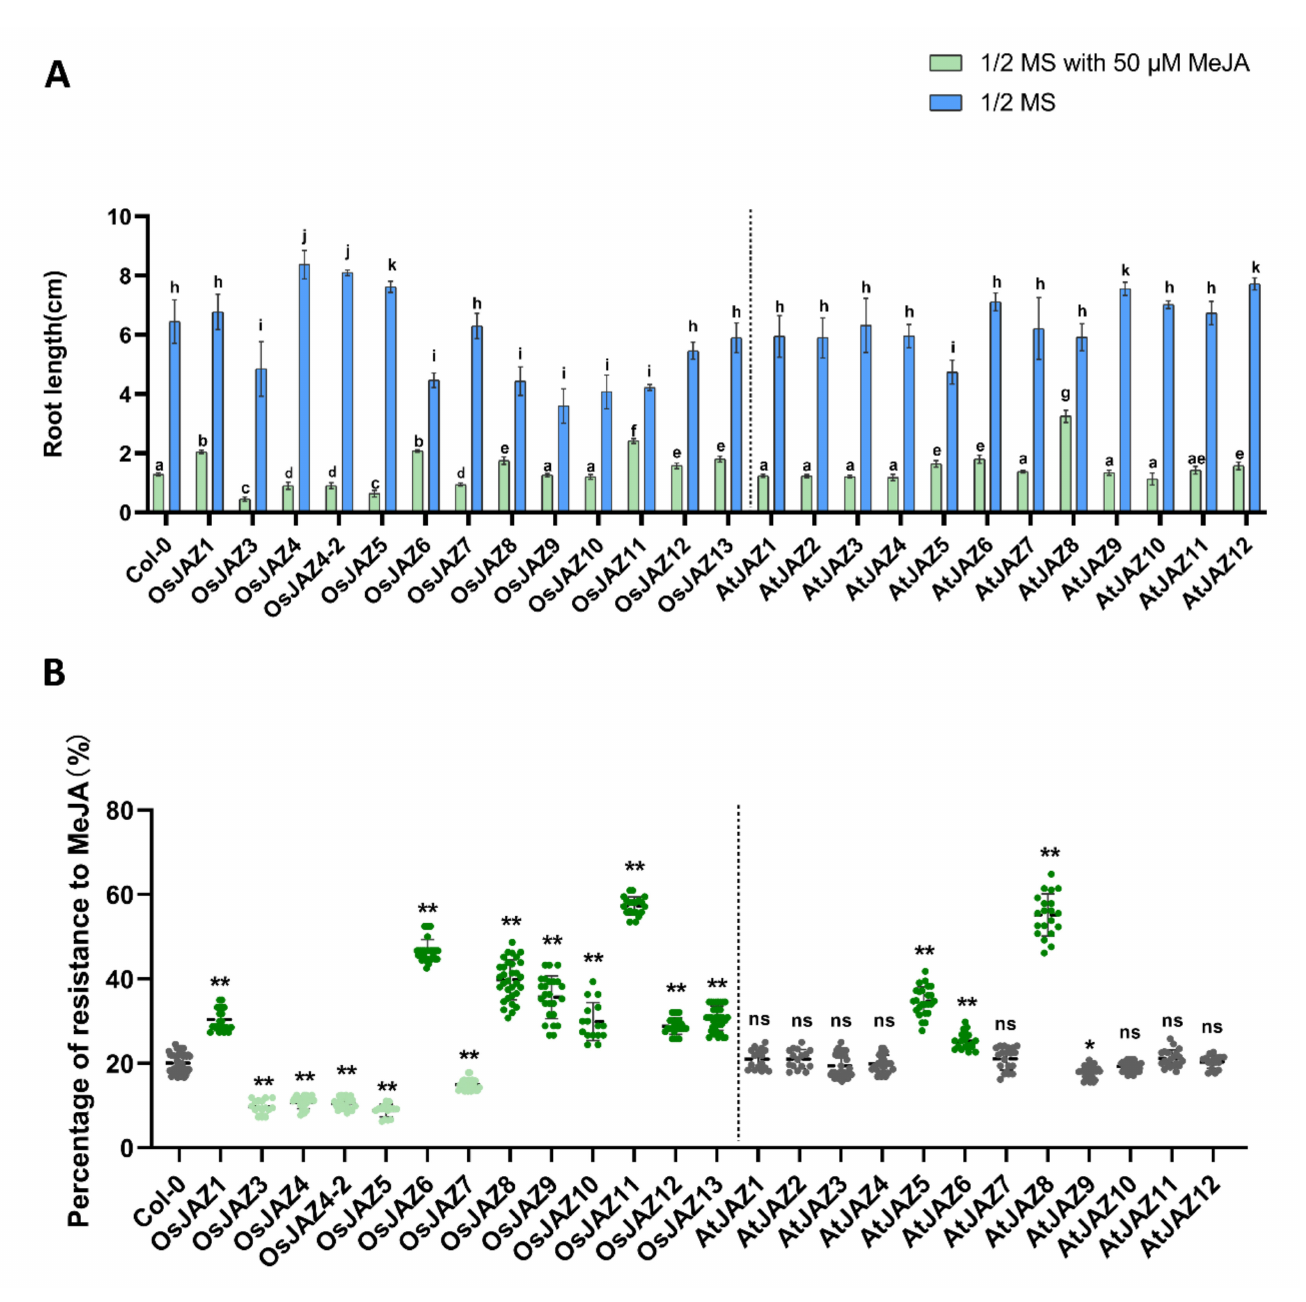
Figure 2. Function of JAZs in root length determination. ( A ) root length of plants grown on 1/2- strength MS medium. Root length was measured after 10 days of vertical culture on 1/2-strength MS media supplemented with 50 µ M MeJA (green) or without MeJA (blue). Different letters represent significant differences among JAZ OE plants or JA treatments ( p < 0.05). ( B ) The dark green points represent the MeJA resistance of the transgenic line being higher than that of Col-0, the light green points represent the MeJA resistance being lower than that of Col-0, and the gray points represent that there is no significant difference in the MeJA resistance of the transgenic line compared with Col-0 (except AtJAZ 9 OE). The data shown are the means ± SEs ( n > 12) (*, p < 0.05; **, p < 0.01; ns, no significance; Student’s t